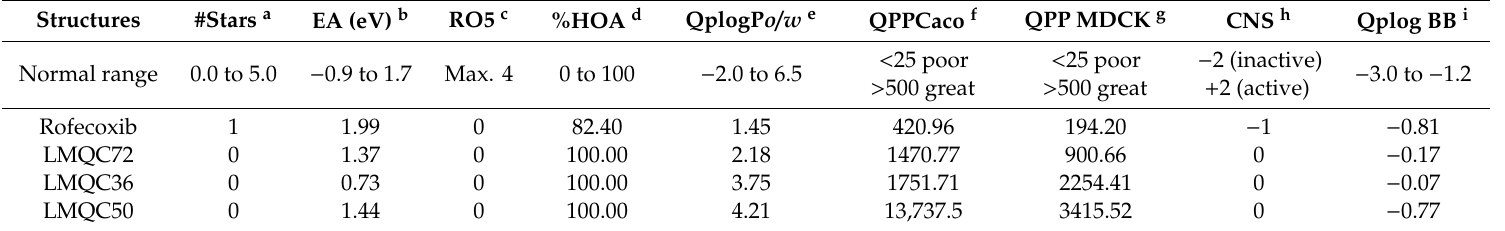
Table 1. Pharmacokinetic properties of the selected